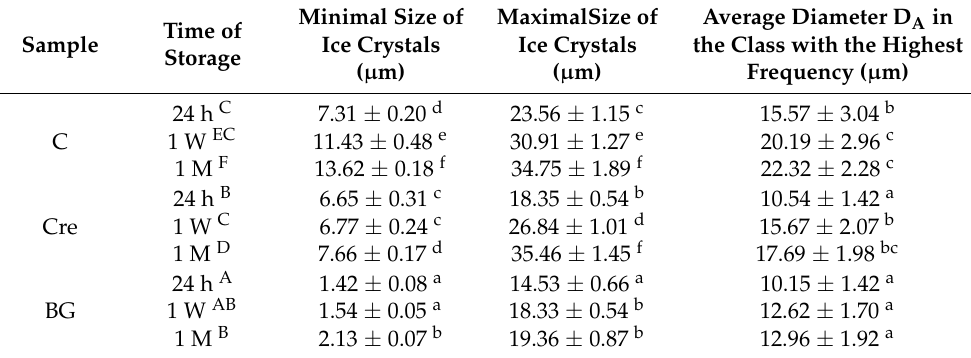
Table 2. Comparison of ice crystals size distribution in ice cream samples after different storage times. Minimal Size Time of Sample Storage